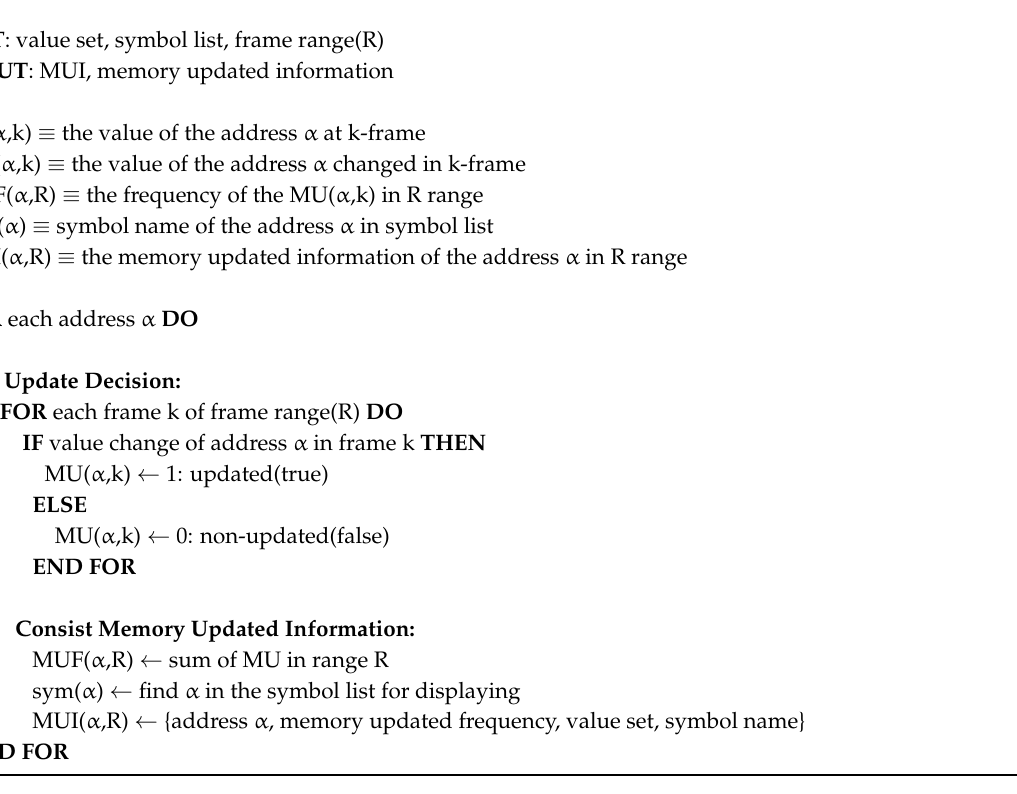
Algorithm 1. The Algorithm for Memory Updated